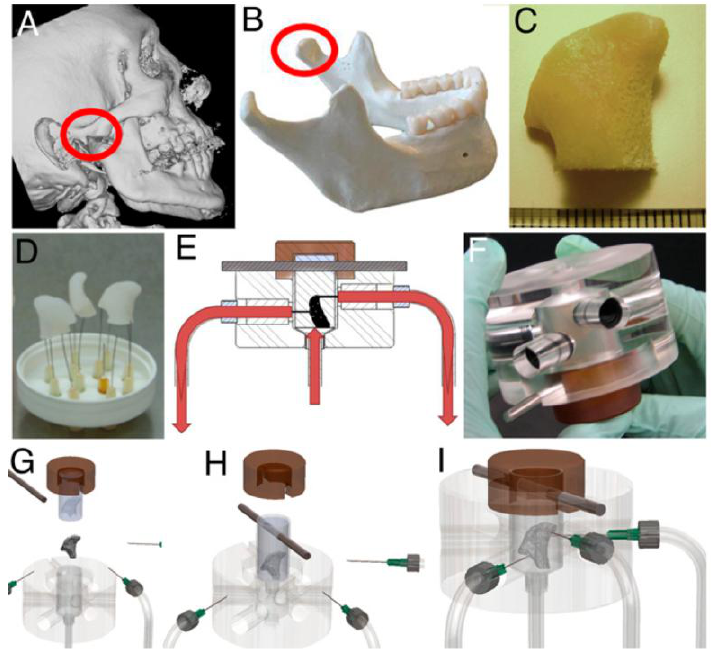
Figure 2. Tissue engineering of anatomically shaped bone grafts using 3D flow. ( A , B ) computed tomography (CT) images were used for the reconstruction of exact geometry of temporomandibular joint (TMJ) condyles. ( C ) Scanned data were used to machine TMJ- shaped scaffolds from fully decellularized trabecular bone. ( D ) Image of produced scaffolds. ( E ) Human mesenchymal stem cells (hMSCs) were statically cultured for 1 week in the scaffolds, and then the perfusion was applied for additional 4 weeks. ( F ) Image of the perfusion bioreactor. ( G (cid:177) I ) Key steps in bioreactor assembly. Reprinted with permission from the National Academy of Sciences of the United States (Grayson et al.